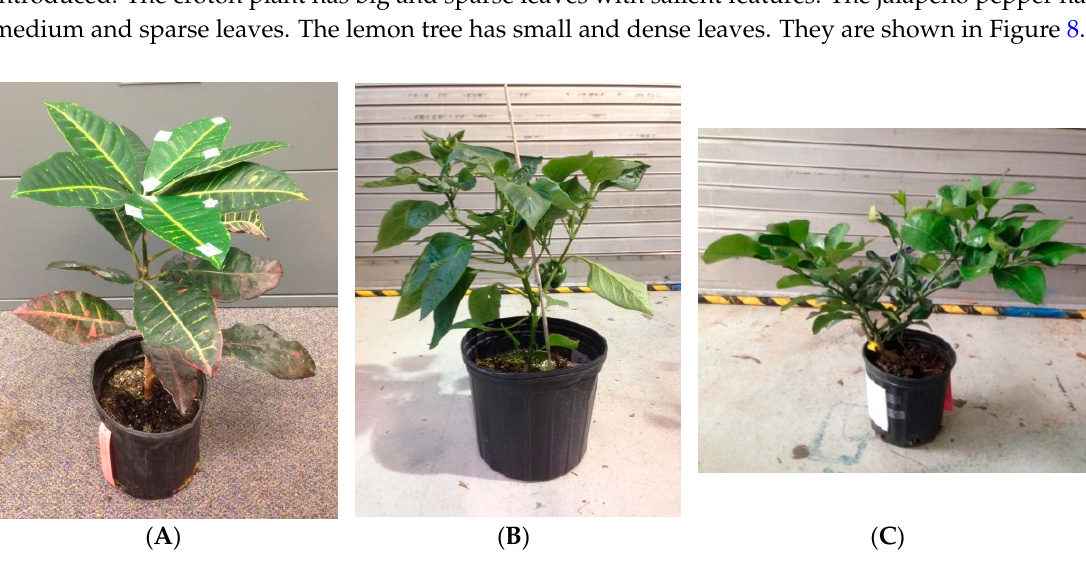
Figure 8. Experimental plants/tree: ( A ) Croton plant; ( B ) Jalapeno pepper plant; ( C ) Lemon tree.